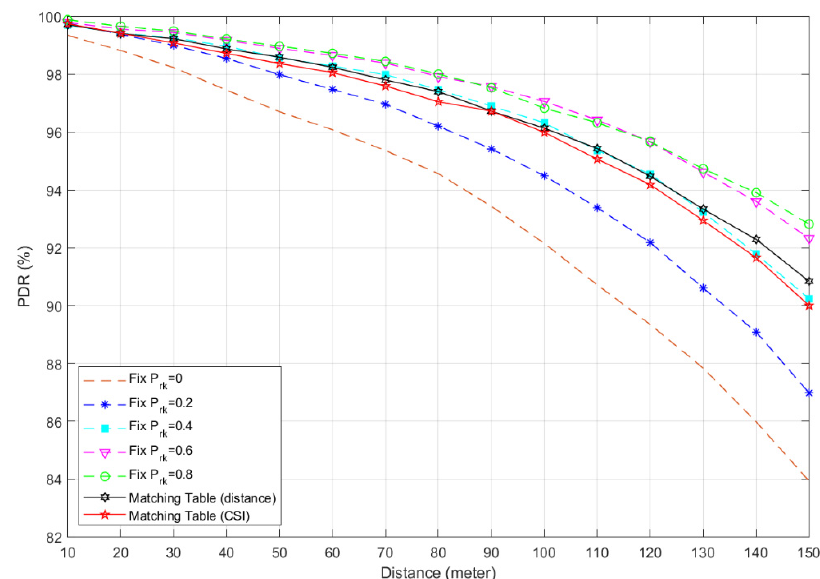
Figure 1. PDR performance comparison of matching table and fixed P rk value for n V = 200-vehicle scenario.